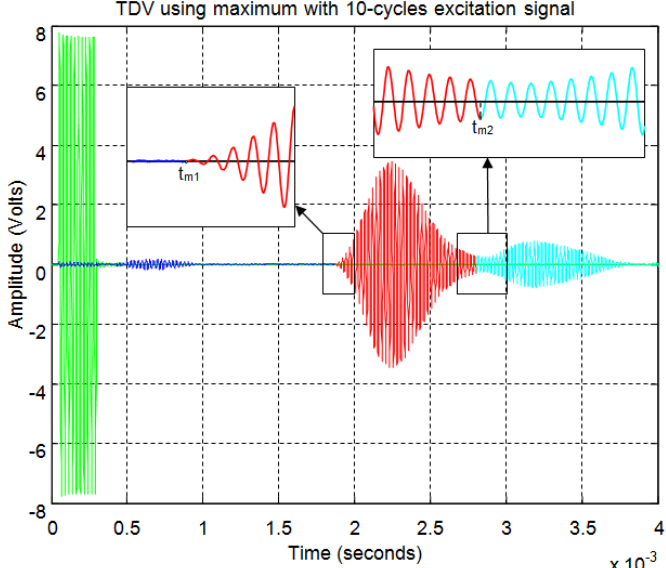
Figure 25. Start time using maximum for an echo formed by two overlapping